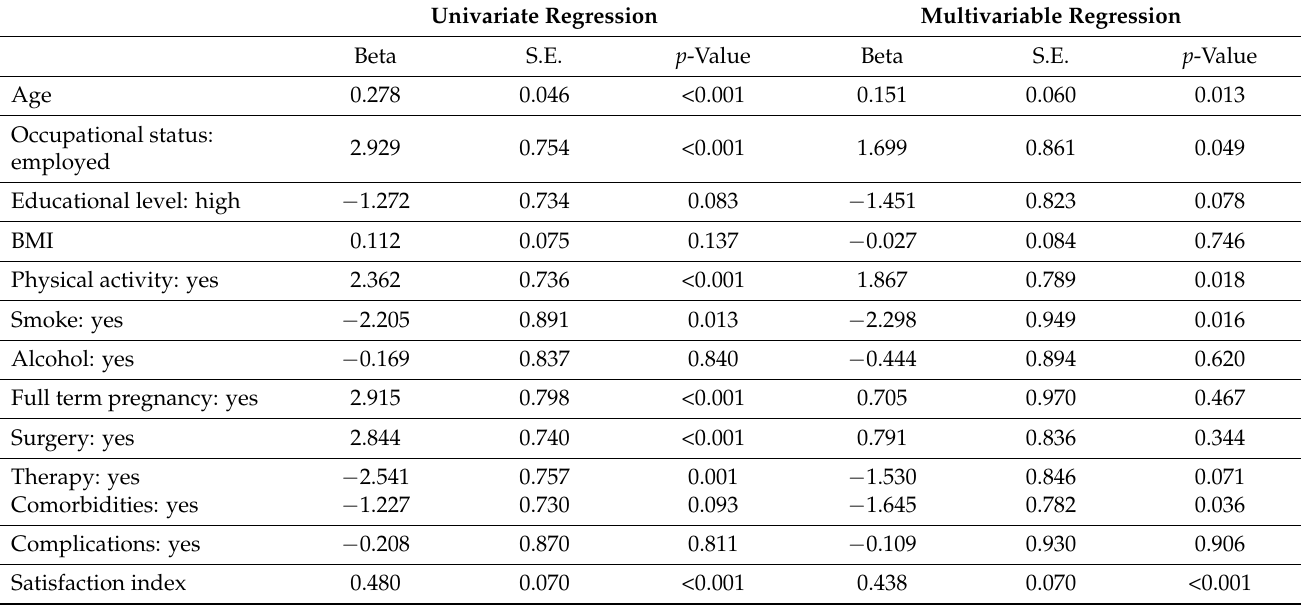
Table 5. Predictors of high level of MCS ( n = 875 *). Univariate